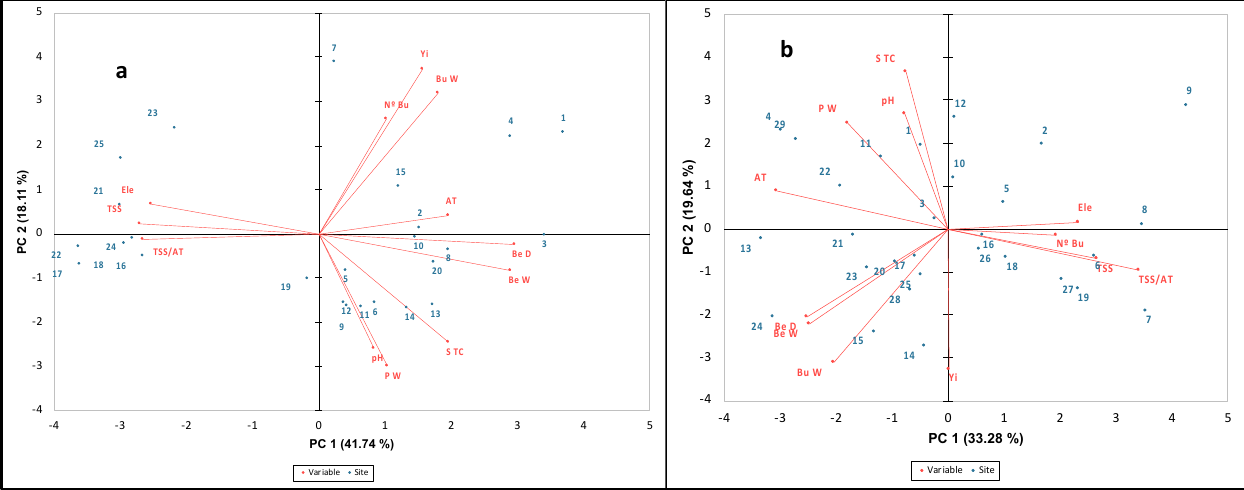
Figure 5. Principal component analysis for slope ( a ) and flat ( b ) vineyards, including all the measured variables. Nomencla- ture: Ele: Elevation. TSS: Total soluble solids. TSS/AT: Maturity index. N ◦ Bu: Number of clusters. Yi: Yield Bu W: